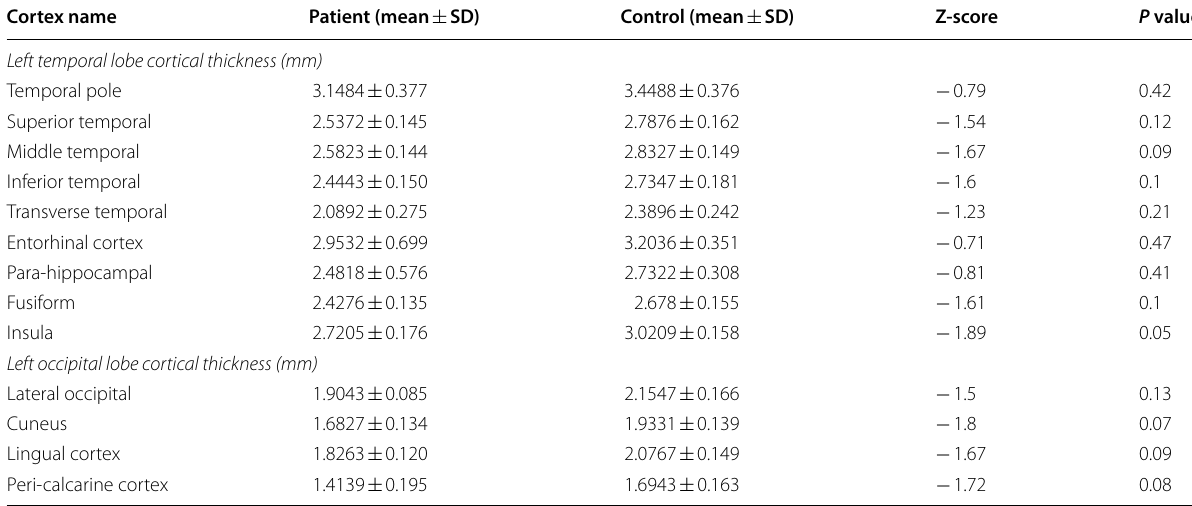
Table 4 Quantitative results of the cortical thickness in mm of the left temporal and occipital lobe areas in mm for patients and control groups, Z-scores and P